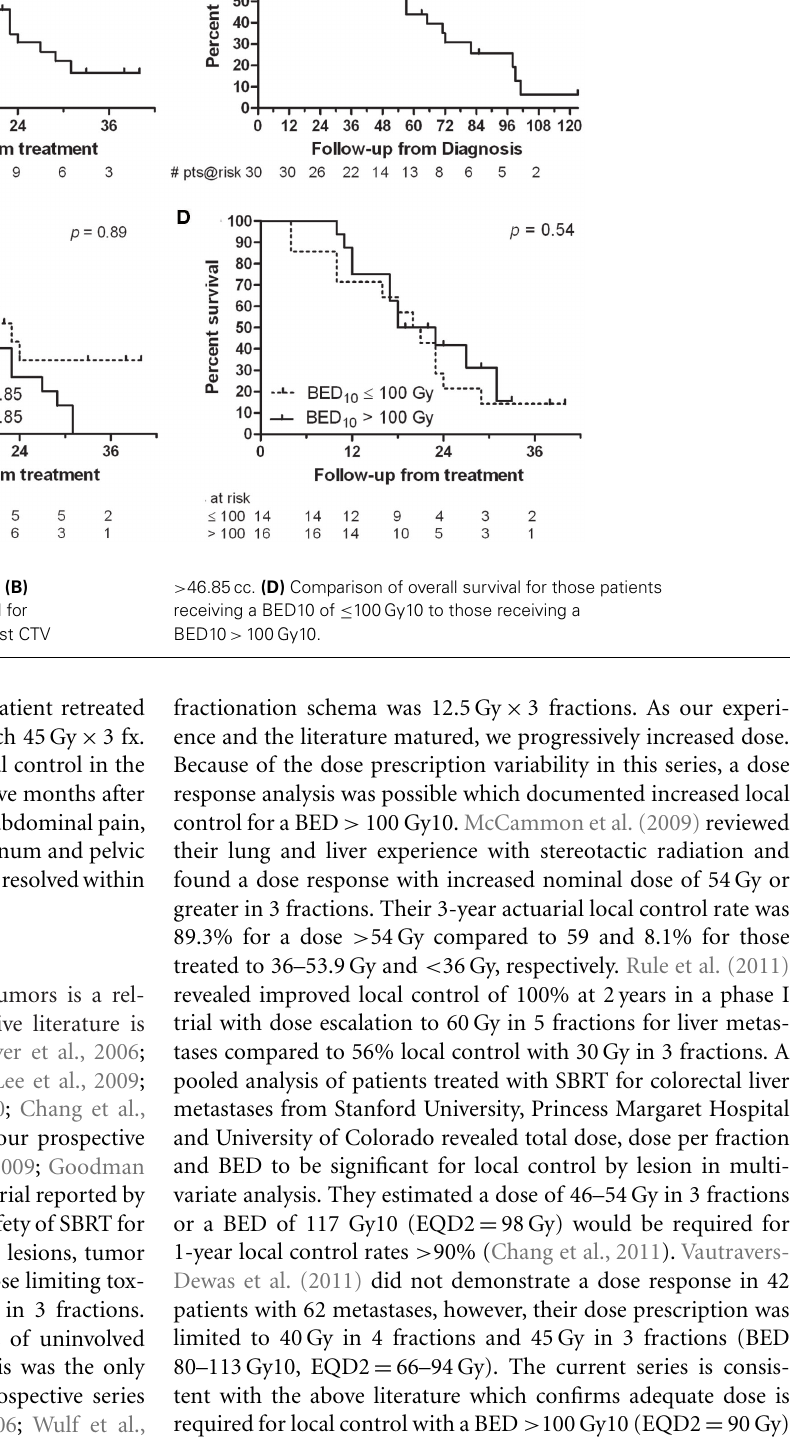
> 46.85cc. (D) Comparison of overall survival for those patients receiving a BED10 of ≤ 100Gy10 to those receiving a BED10 >